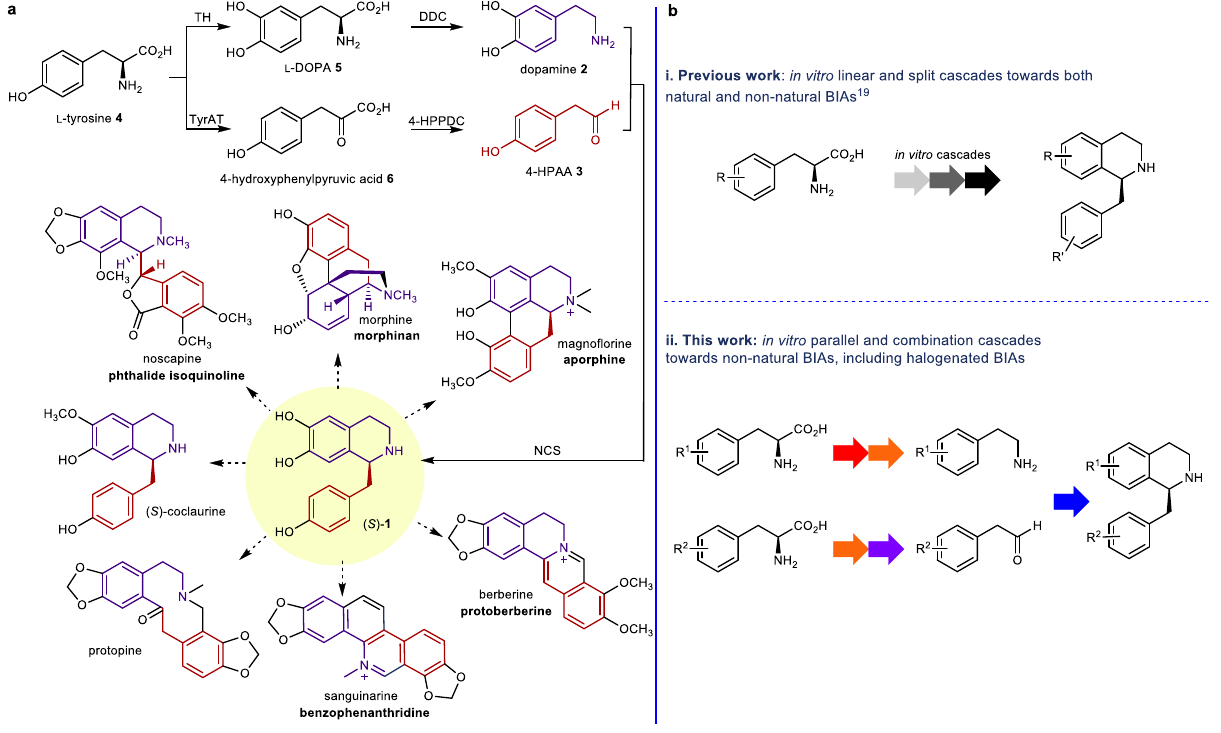
Fig. 1 | Biosynthetic and biocatalytic routes to BIAs and a parallel cascade adopted in this work. a Biosynthetic BIA pathway in plants and examples of the alkaloid formed. L-Tyrosine 4 is converted to L-DOPA 5 by tyrosine hydroxylase (TH),thentodopamine 2 byDOPAdecarboxylase(DDC).Inaparallelpathway, 4 is converted into 4-HPAA 3 via 4-hydroxyphenylpyruvic acid 6 by tyrosine amino- transferase (TyrAT) and 4-hydroxyphenylpyruvate decarboxylase (4-HPPDC).